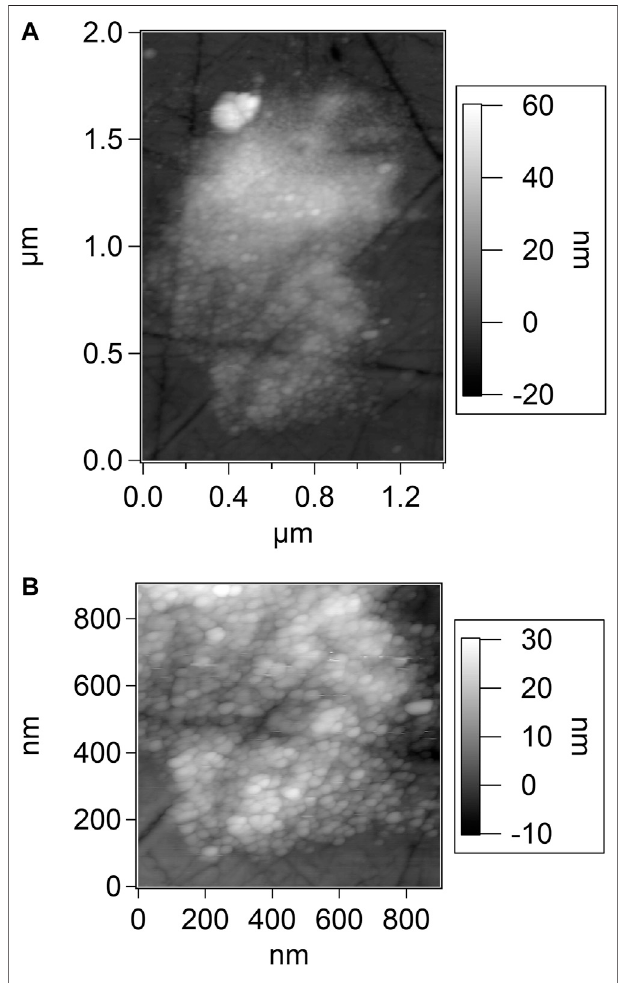
FIGURE12| Agglomerationofwearparticlesclosetothereversalpoints of a track. (A) is an overall image, (B) a detail.